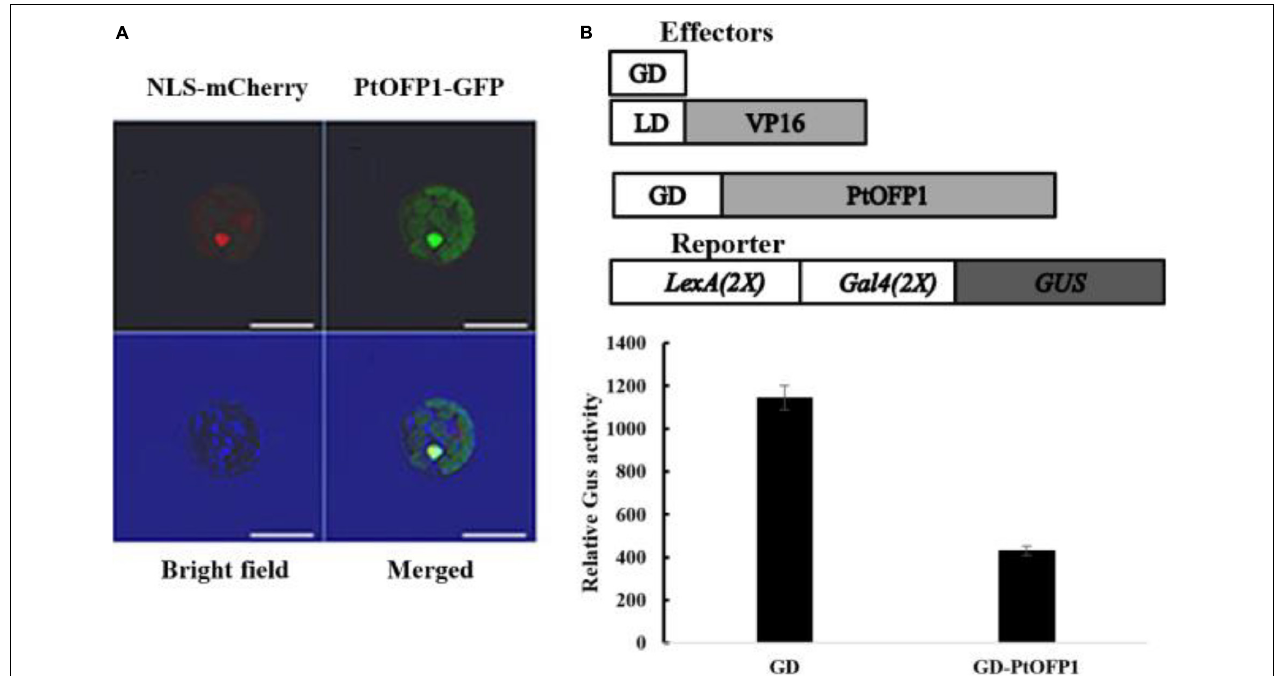
FIGURE 5 | PtOFP1 is a transcriptional repressor. (A) Subcellular localization of PtOFP1. The nuclear marker NLS-mCherry was used as an indicator for the nucleus. Scale bars = 10 µ m. (B) PtOFP1 transcriptional activity analysis. Plasmids of GD-PtOFP1 or GD alone (as a control) were co-transfected with a LexA-Gal4-GUS reporter into the protoplasts isolated from the Populus leaves. Transfected protoplasts were incubated in the darkness for 20–22 h before GUS activities were measured. Data represent mean ± SD of three replicates. Effectors and reporter used were diagrammed on the top of the